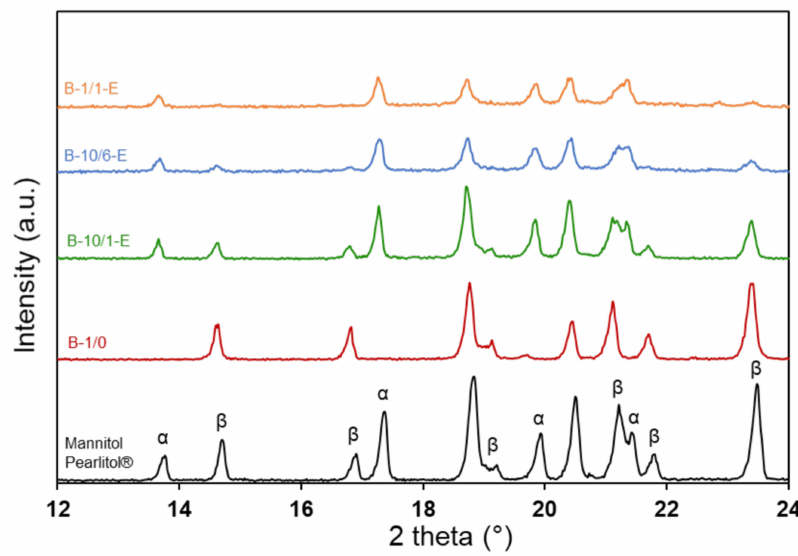
Figure 6. Influence of the M/PS ratio on the polymorphism of mannitol: XRD patterns of the spray‑ dried granules after etching (lab‑scale Büchi spray dryer